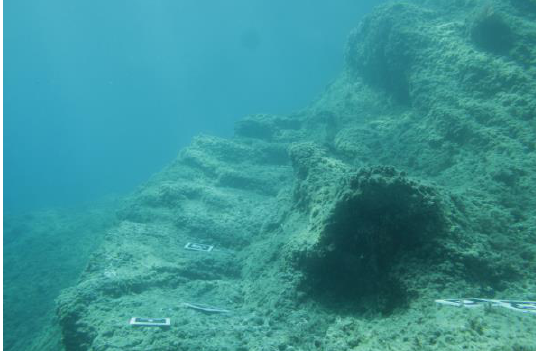
Figure 16. Prehistoric scale, Gulf of Genito, Vivara-Procida